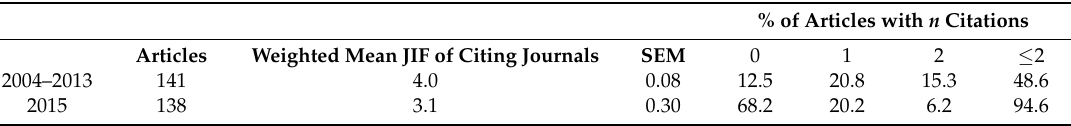
Table 8. Citation rates and weighted mean JIFs of citing journals for Medicine articles by authors at the ten most common 2004–2013 institutions, pre- and post- mega-journal